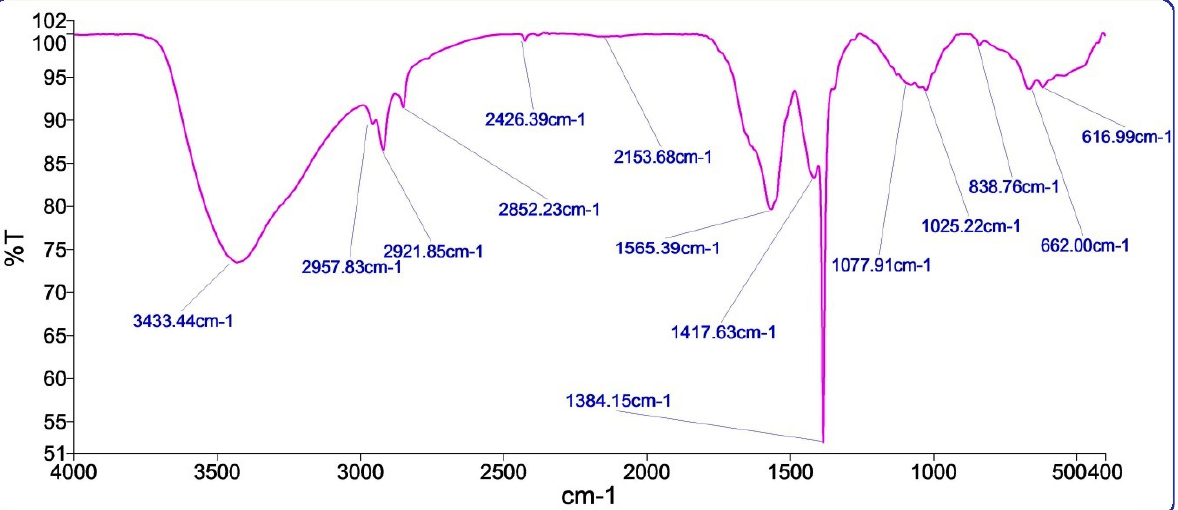
Figure 2. FTIR spectra of Cu-Mn bimetallic nanoparticles.